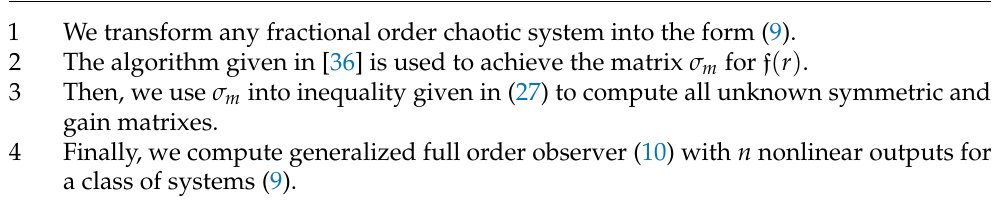
Algorithm 1 Generalized full order observer for a class of fractional order chaotic